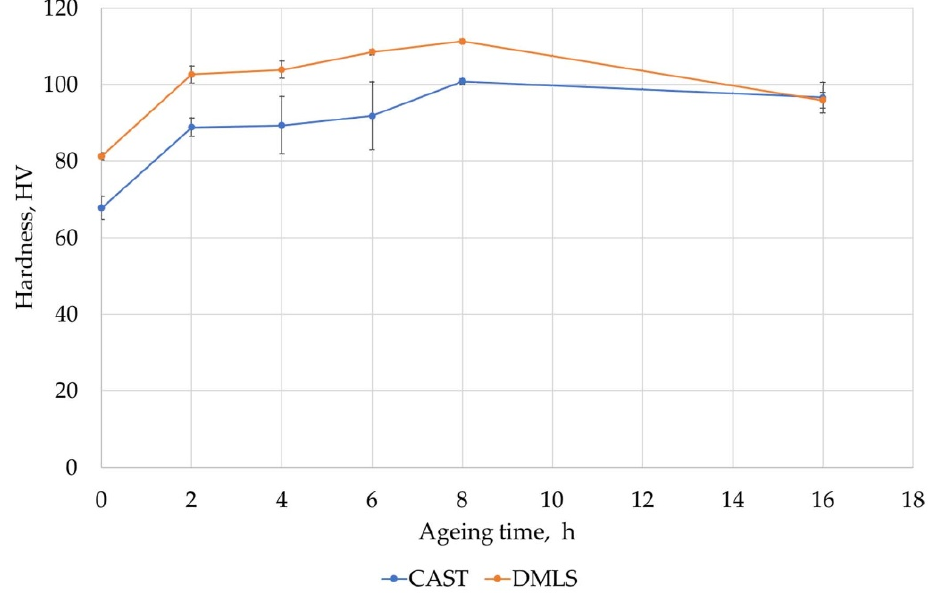
Figure 16. Hardness distribution for cast and DMLS samples depending on the ageing time (temperature 170 °C).